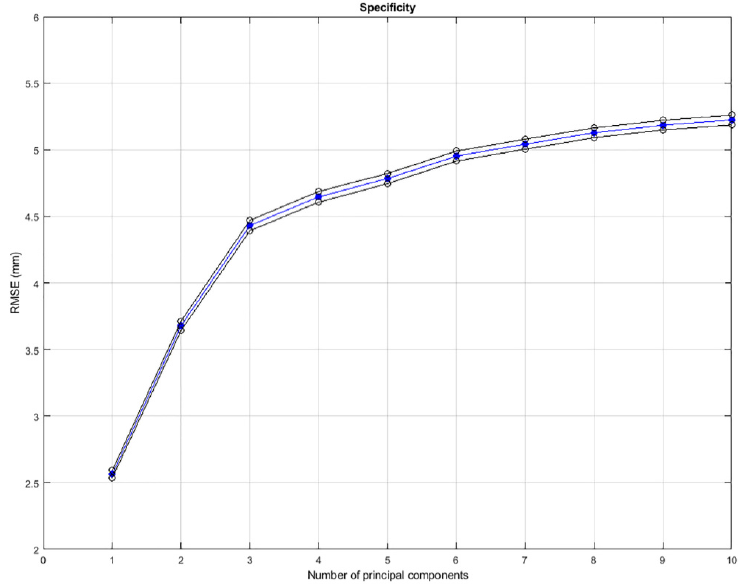
Figure A2. Graph of the specificity of the statistical shape model (SSM); mean specificity and the 95% confidence intervals are given. The mean specificity for five principal components (PCs) is 4.8 (95% CI: 4.7–4.8) mm.